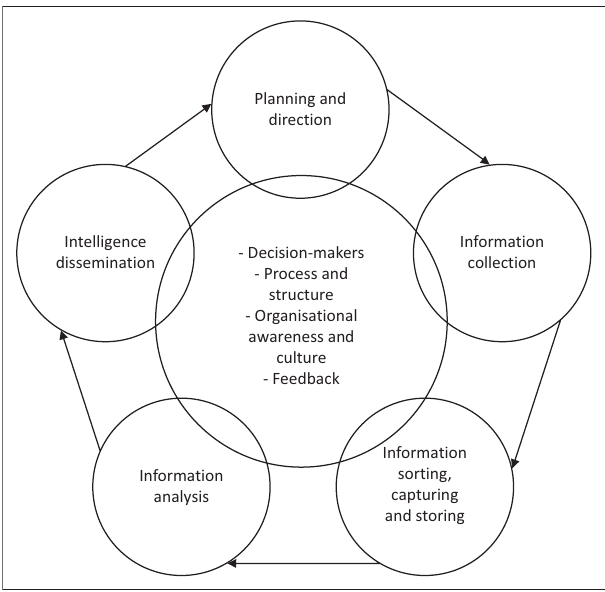
FIGURE 1: Competitive intelligence